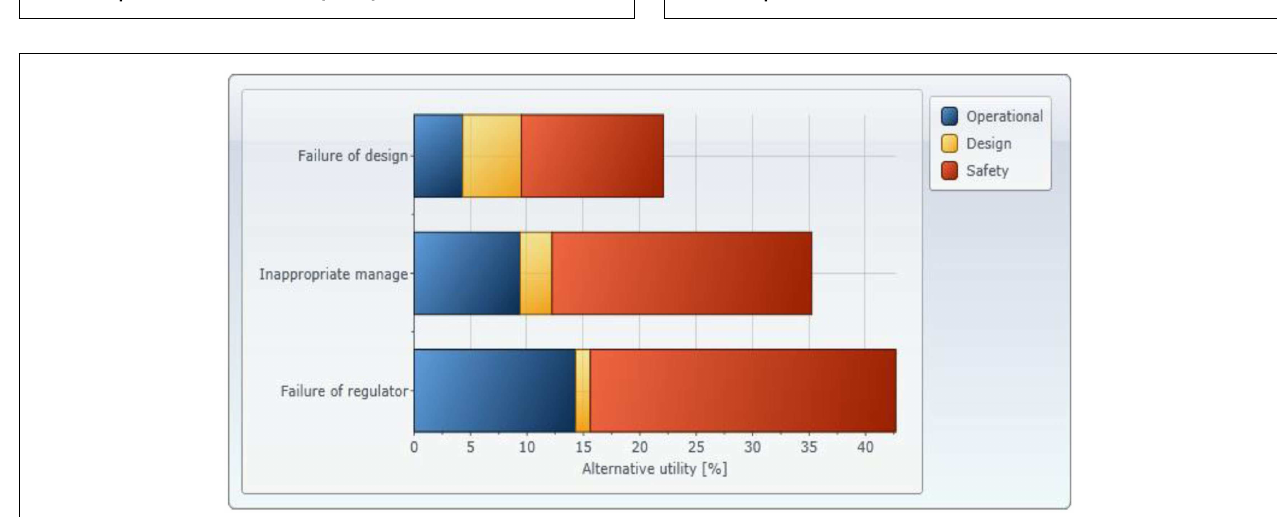
FIGURE 6 |AHP model for reliability analysis . FIGURE 8 | Selection of best alternative .